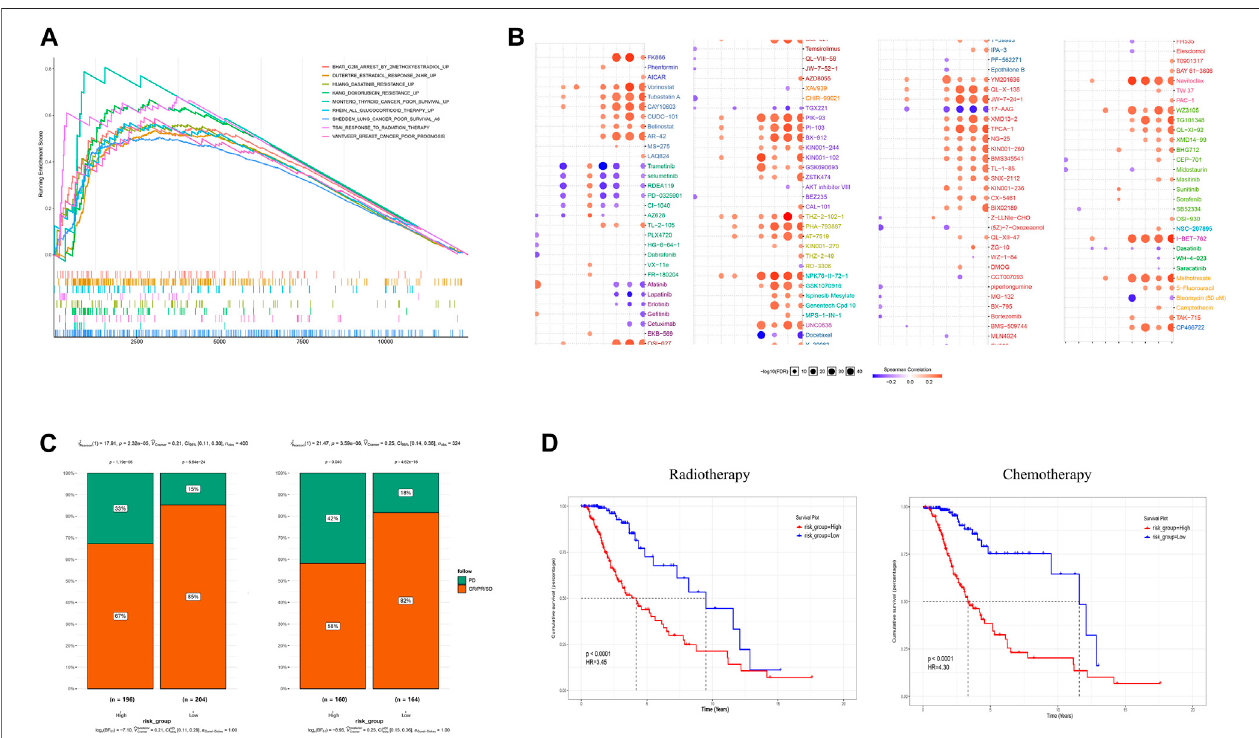
FIGURE6| Thegenesignatureisagood markerofresistancetovarious treatments. (A) AhighGRSscorecorrelatedwiththerapeuticresistance. (B) Alandscape graphillustratingthedrugsensitivity(IC50)ofmembersoftheGRSsignatureinLGGcells. (C) Theclinicalbene fi trate(CBR)waslowerinthehighGRSscoregroupsboth in follow-up treatment outcome terms and primary treatment outcome terms. (D) Patients with a higher GRS score had a worse OS among those that received chemotherapy and radiotherapy. CBR: CR + PR + SD (CR, complete remission; PR, partial remission; SD, stable disease; PD, progressive disease) IC50, half maximal inhibitory